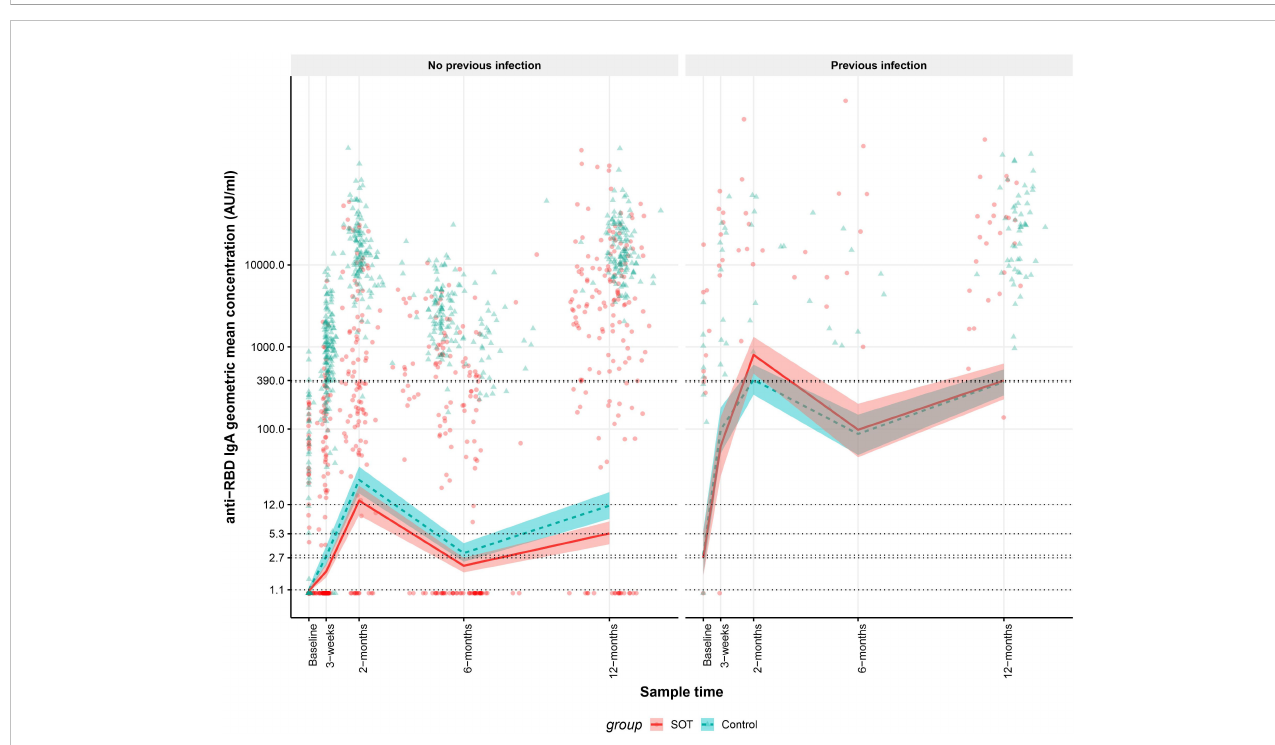
FIGURE 4 Kinetics of the modeled anti-receptor-binding domain (RBD) Immunoglobulin A (IgA) geometric mean concentrations (GMCs) in solid organ transplant (SOT) recipients and controls with and without previous infection within 12 months after the fi rst BNT162b2 BNT162b2 and observed anti-RBD IgG concentrations. The data include 204 SOT recipients (red) and 204 age and sex matched controls (blue). A sample is de fi ned as previously infected, when an individual has a positive SARS-CoV-2 PCR test prior to the sample or SARS-CoV-2 Nucleocapsid antibodies are present in the sample or a previous sample from the same individual. The modeled anti-RBD IgA GMCs in AU/mL with 95% con fi dence intervals are plotted on top of each indiviudal sample ’ s measured anti-RBD concentration in AU/mL. The y-axis is on a log10 scale. The dashed horizontal lines indicate modeled anti-RBD IgA GMC values for SOT recipients and controls with and without prior infection at baseline and 12 months after fi rst BNT162b2